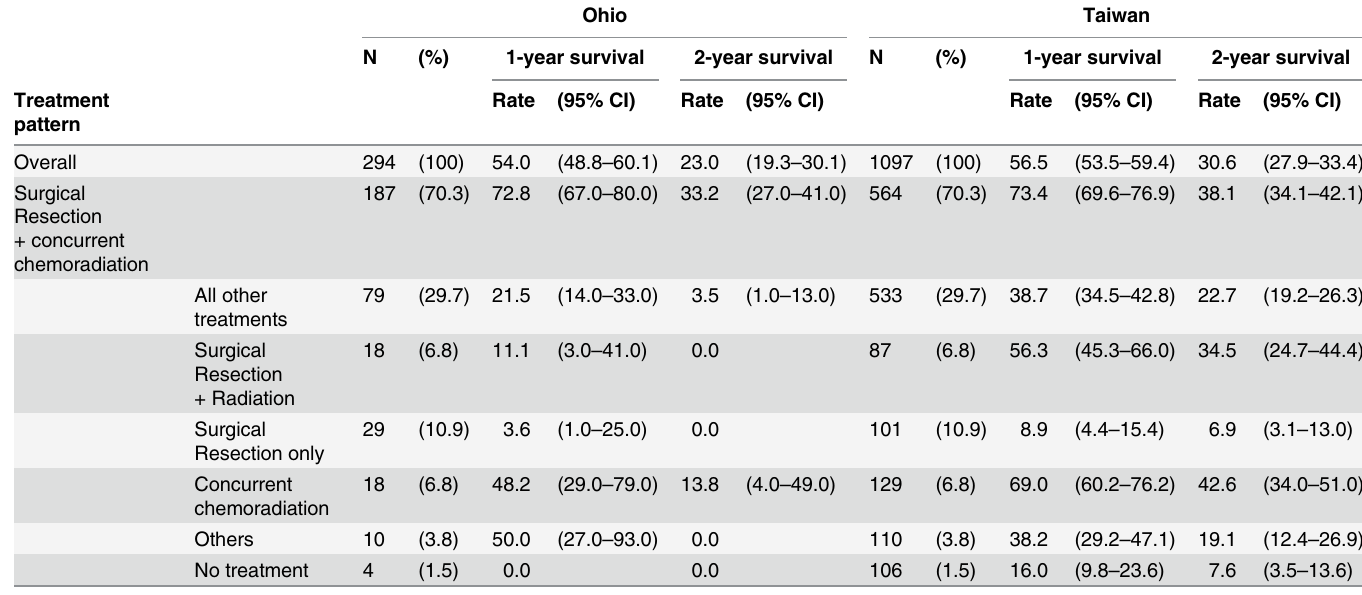
Table 2. Survival Rates stratified by treatment pattern for Patients Diagnosed with the High Grade Glioma in Ohio and